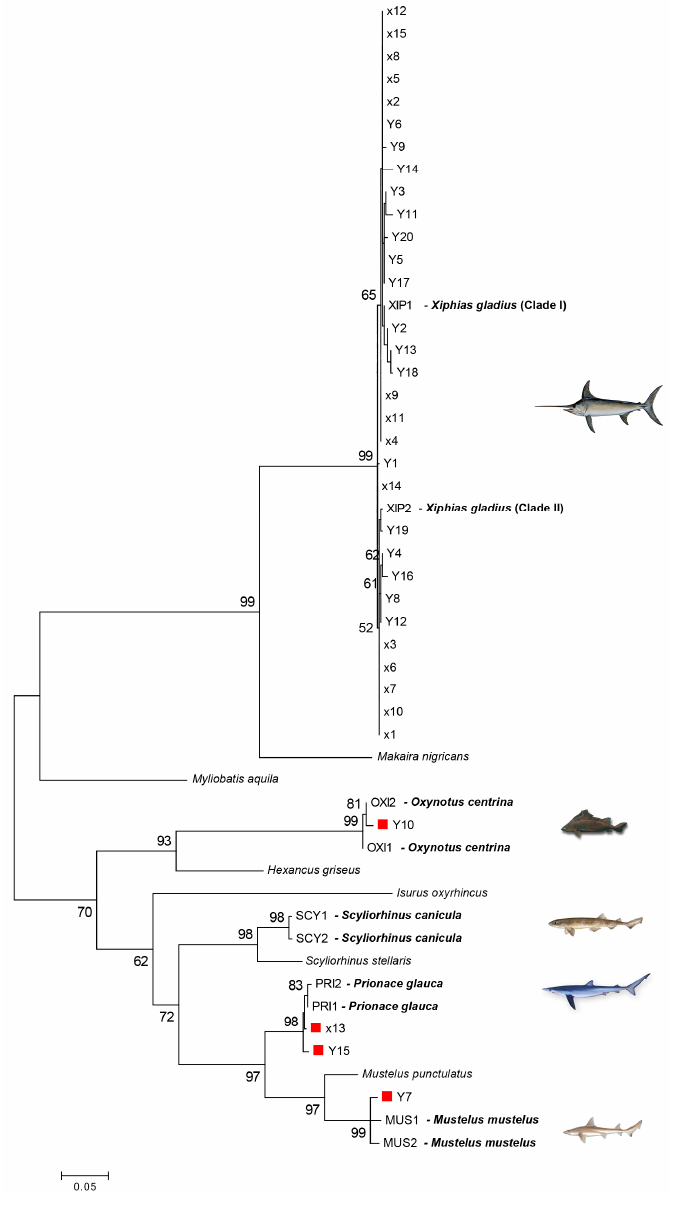
Figure 2. Maximum likelihood (ML) tree showing the relationships of unknown samples sequences (X and Y) to validated reference barcode sequences. The numbers above the nodes represent bootstrap analyses after 1000 replicates. Bootstrap values greater than 60% are shown. The red square indicates swordfish mislabeled samples. Scale bar refers to a distance of 0.05 nucleotide substitutions per site.